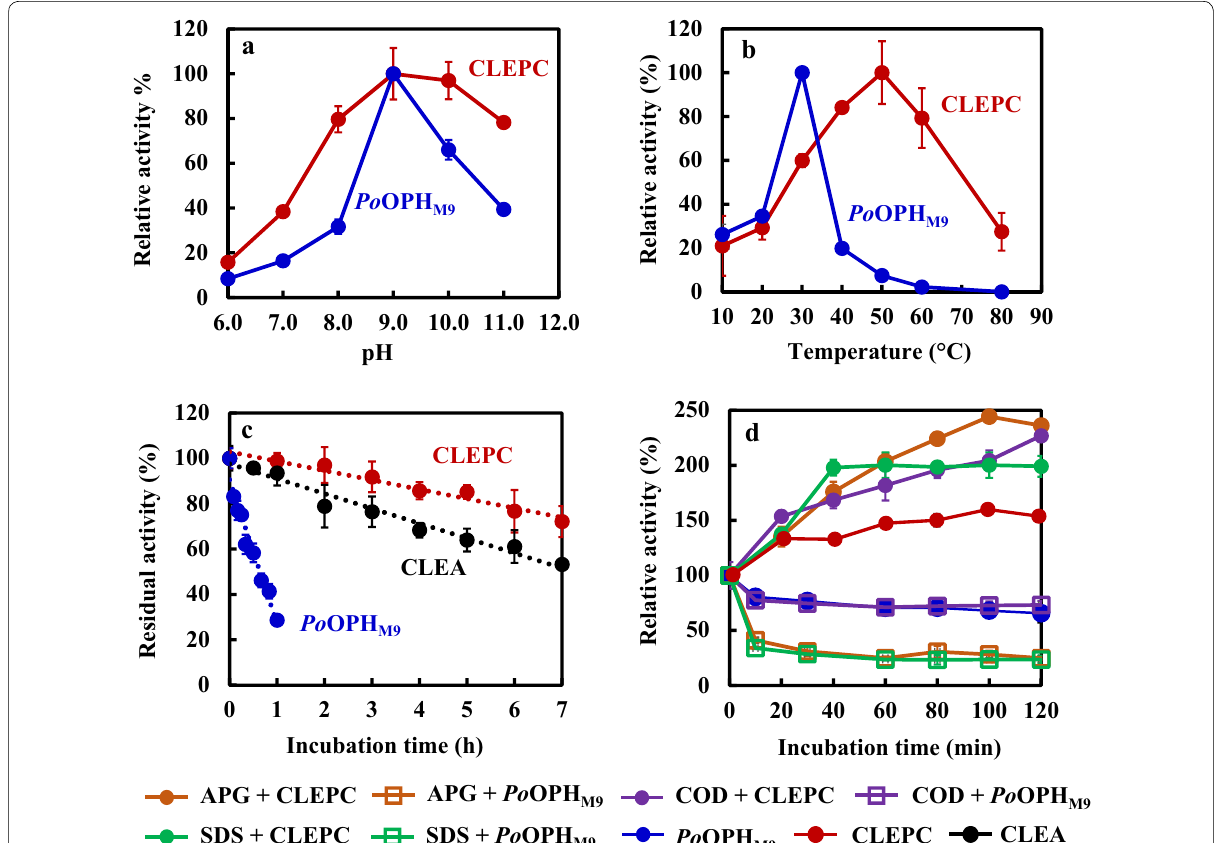
Fig. 3 Enzymatic assay of Po OPH M9 CLEPC. The optimal pH ( a ) and temperature ( b ) of CLEPC and free enzymes were determined. Thermostability ( c ) was investigated by measuring the residual activity of different catalysts incubated at 50 °C. d The relative activity of CLEPC and Po OPH M9 incubated in the presence of 0.1% (w/w) detergents were measured at 25 °C. The relative activity of Po OPH M9 CLEPC in the absence of detergents was also measured (red